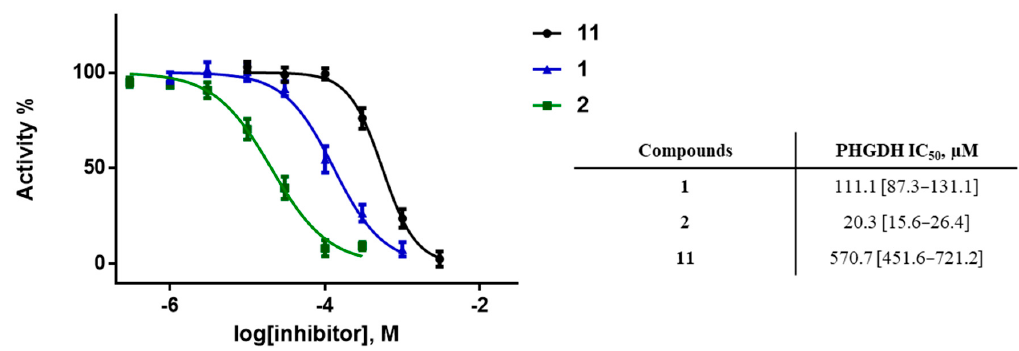
Figure 4. Dose–response curves of compounds 1 , 2 , and 11 on isolated PHGDH. IC 50 values were determined from two independent experiments performed in triplicates at each compound dilution, in brackets: 95% confidence